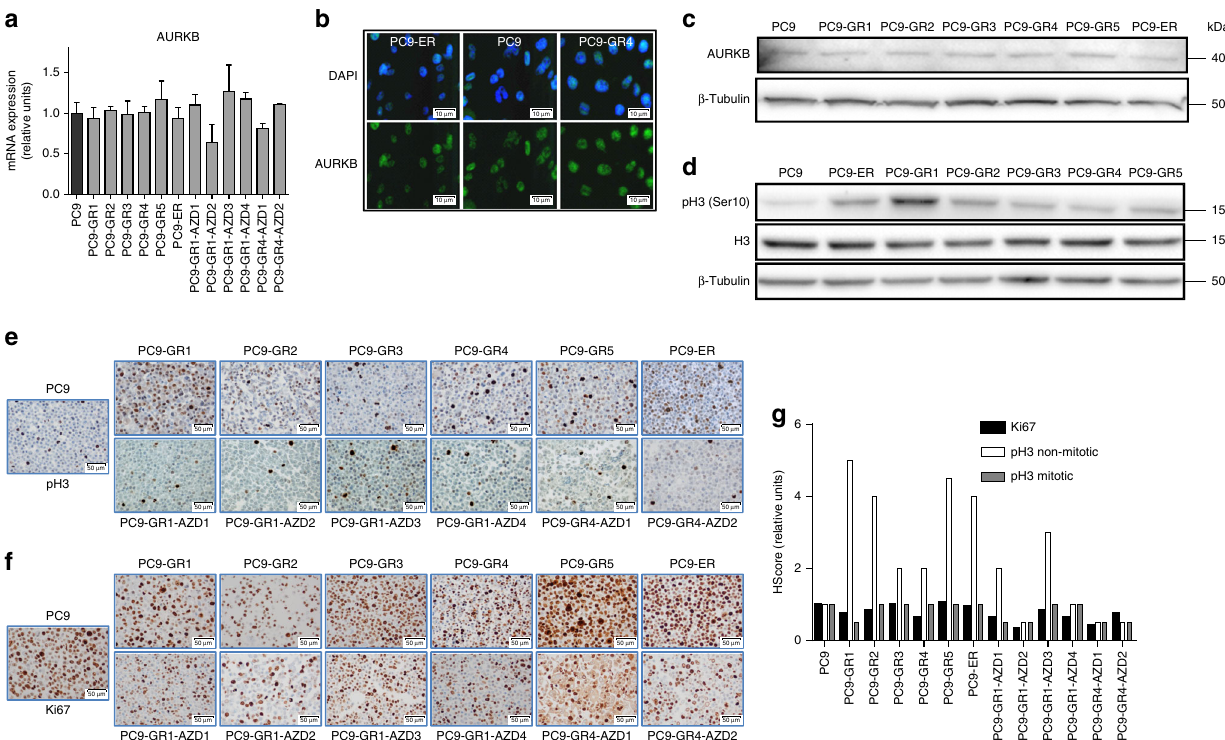
Fig. 2 AURKB and pH3 in PC9-derived cell lines resistant to EGFR TKIs. a Levels of AURKB mRNA in the cells of the panel. Values shown are means ± SD of three independent determinations ( n = 3). b Levels of AURKB by ICC in the parental PC9 and the resistant lines PC9-ER (p.T790M negative) and PC9-GR4 (p.T790M positive). Scale bars indicate 10 μ m. c Levels of AURKB in the parental PC9 and the cell lines resistant to fi rst generation EGFR TKIs by western blotting. d Levels of histone H3 and pH3 in the same cell lines by western blotting. e – g IHC of pH3 ( e ), Ki67 ( f ) and H-score of Ki67, mitotic pH3 and non- mitotic pH3 ( g ) in the 12 cell lines resistant to EGFR TKIs. Scale bars indicate 50 μ m. Values shown are means of two blind determinations performed independently by two expert pathologists ( n =